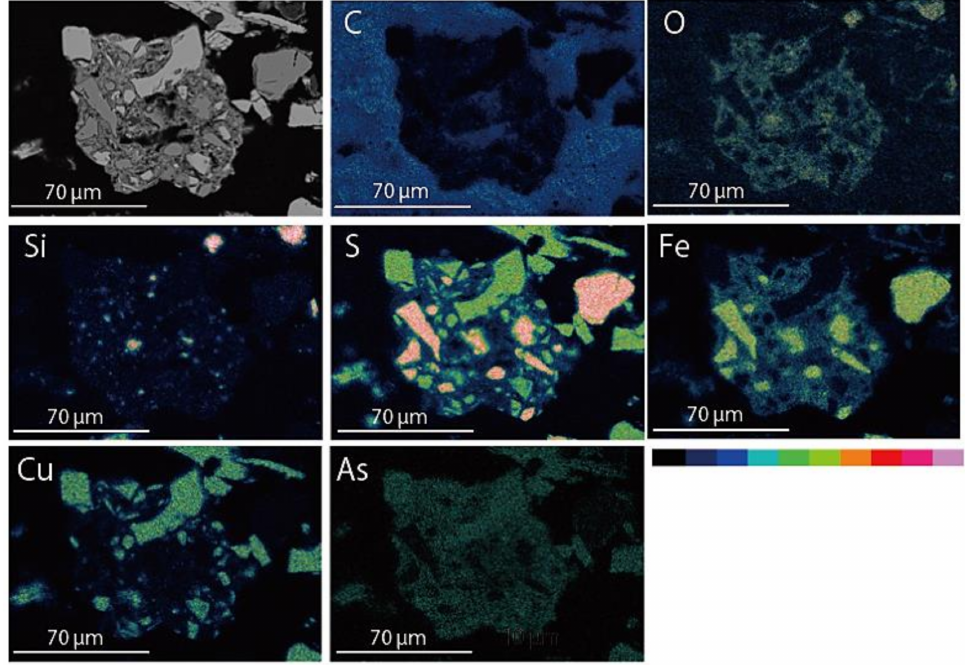
Figure 6. EPMA elemental mapping of DC-II residue bioleached for 60 days at AC 0.05%. The backscattered electron image was mapped for C, O, Si, S, Fe, Cu and